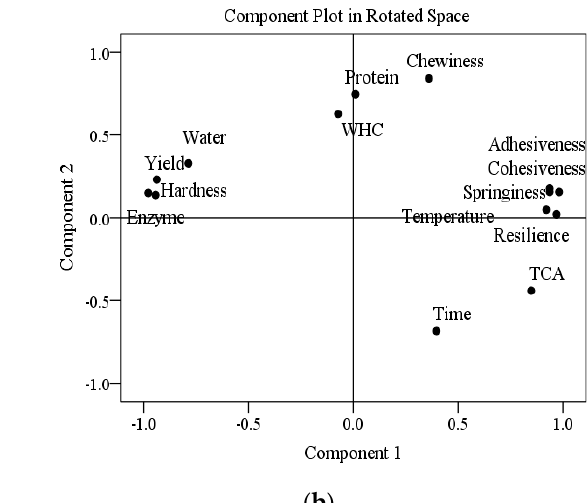
Figure 6. Relative enzyme activity of C. frondosa after various heat treatments, ( a ) comparison of relative enzyme activity during cooking for 45 min at different temperatures (40, 60, 80, and 100 °C), and ( b ) comparison of relative enzyme activity after boiling and steaming at 100 °C for 0–120 min. Different letters (a, b, c, d, e) indicate significant differences between groups as determined via one-way ANOVA ( p < 0.05).